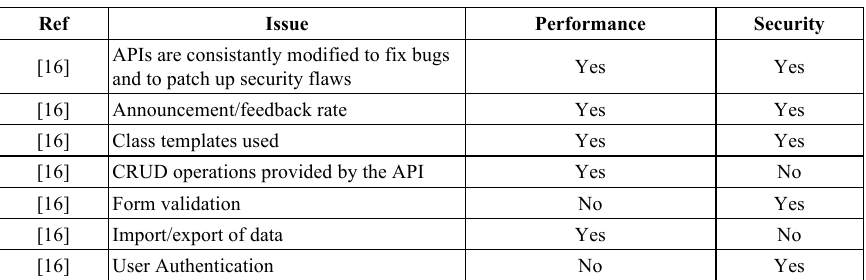
Table 3. Open issues in API design and